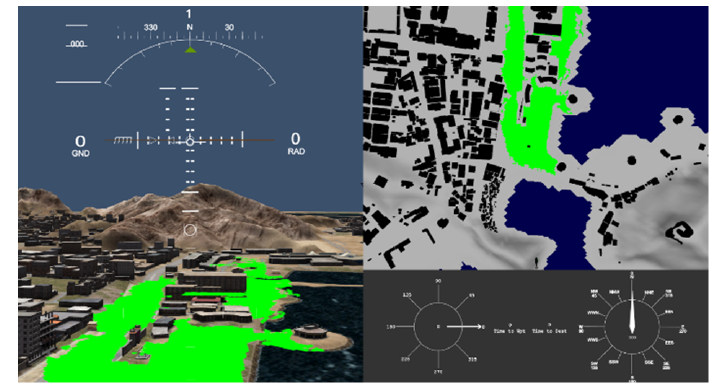
Figure 10. SLZs of Scene 4 projected on Vega Prime.